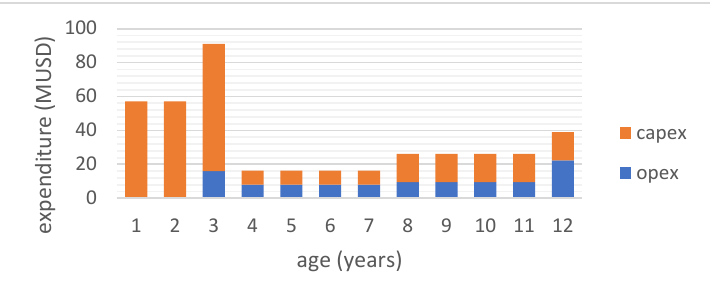
Figure 2. Example of an expenditure timeline for a small deep offshore field in DYNamic UpstreAm GAs Model (DYNAAMO).